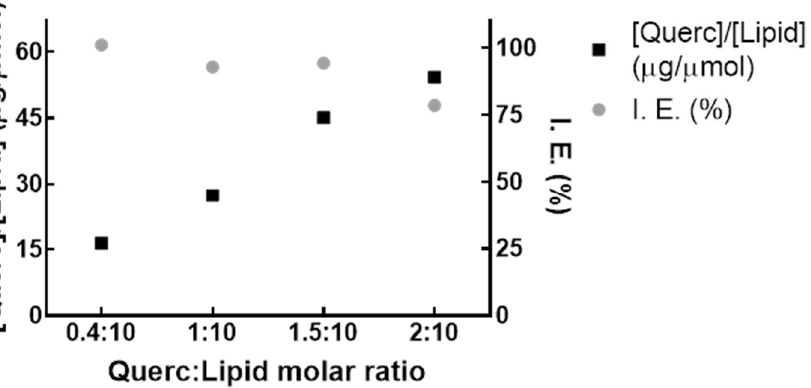
Figure 1. Saturation profile of quercetin liposomes. Saturation curves obtained through the initial molar ratio between quercetin (Querc) and lipid concentrations ([Querc]/[Lipid]) and quercetin incorporation efficiency (I.E.) ( n = 2).